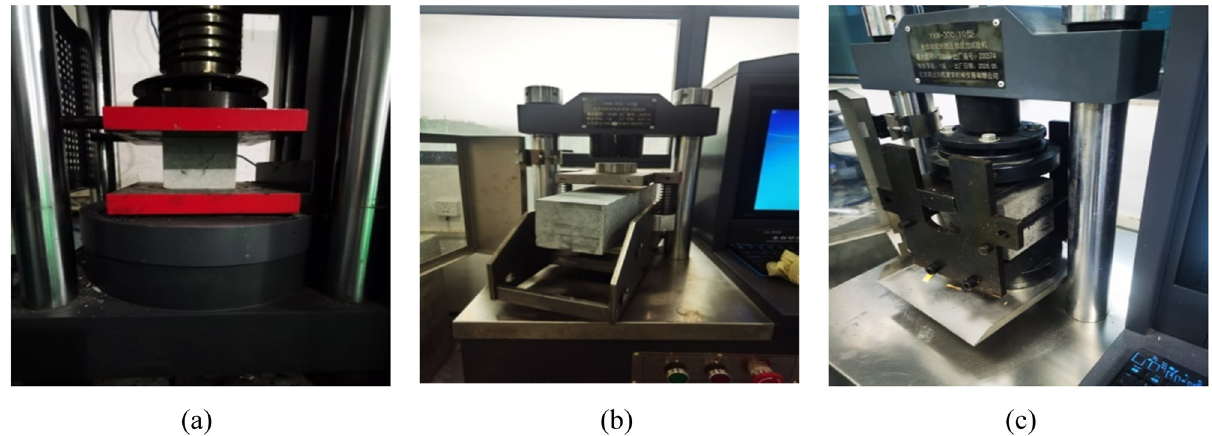
Figure 4: Mechanical properties test of concrete. ( a ) Compressive test. ( b ) Flexural test. ( c ) Splitting tensile test.